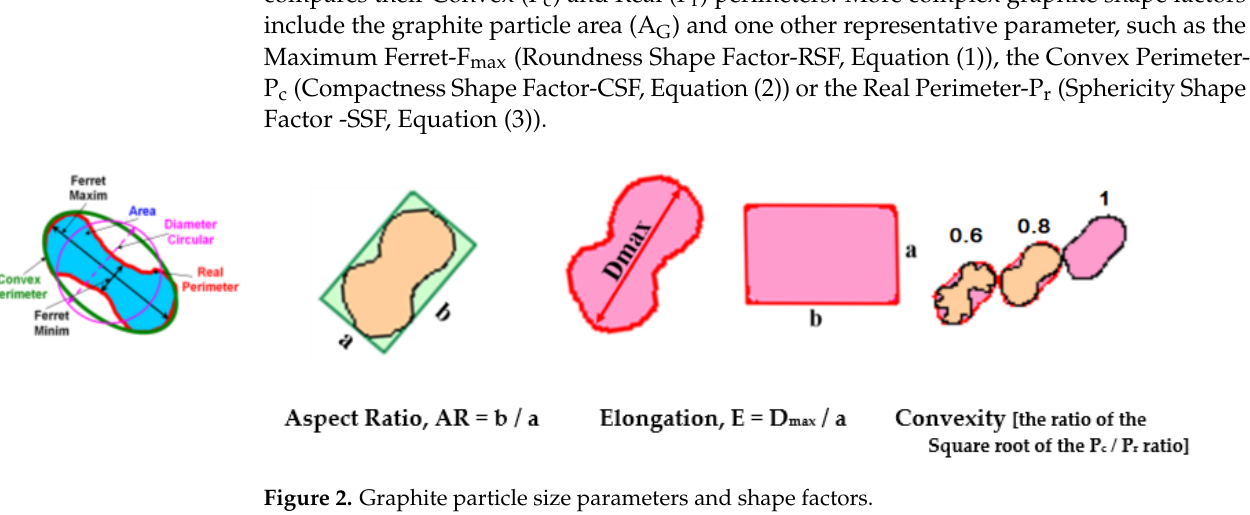
Figure 2. Graphite particle size parameters and shape factors. Roundness Shape Factor: RSF = 4 A G/ π F max 2 Compactness Shape Factor: CSF = 4 πA G /P c2